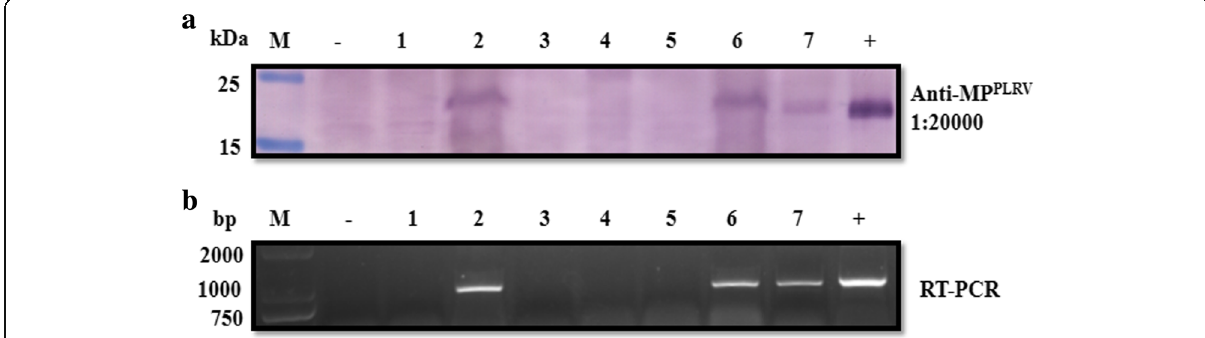
Fig. 5 Comparison of detections of PLRV from field crops using anti-MP PLRV and RT-PCR. a Lane M: PageRuler Prestained Protein Ladder. b Lane M: DL2000 Ladder, lane “ - ” : extract from healthy potato leaf (negative control), lanes 1 – 7: extracts from potato leaf samples collected from individual potato plants, lane “ + ” : extract from PLRV-infected Nicotiana benthamiana leaf (positive